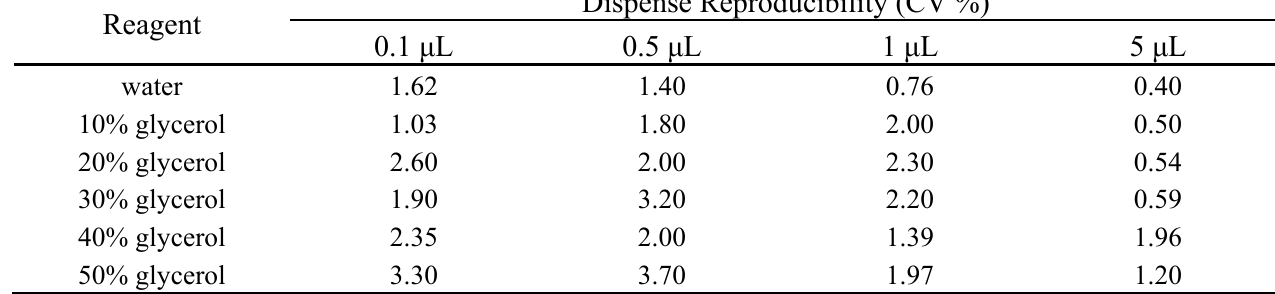
Table 1. Reproducibility of